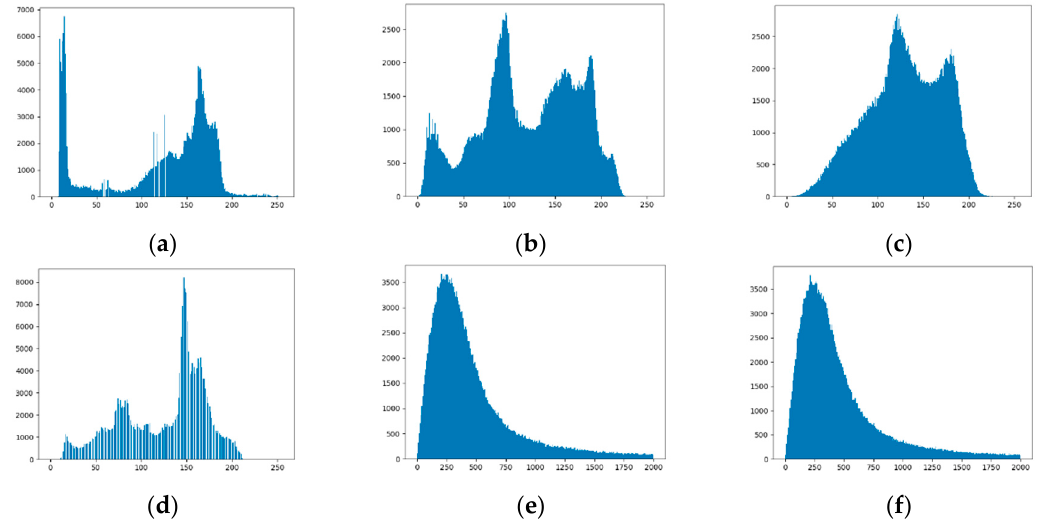
Figure 7. Histogram: ( a – d ) original images, ( e ) encrypted image, ( f ) encrypted image using different original images.